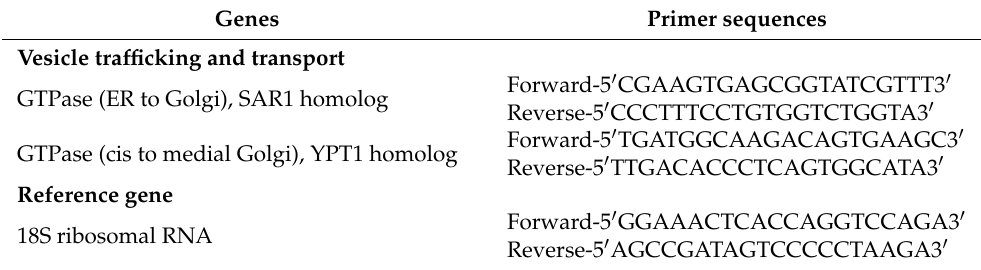
Table 1. List of primers used in the quantitative polymerase chain reaction (qPCR). Genes Primer sequences Vesicle trafficking and